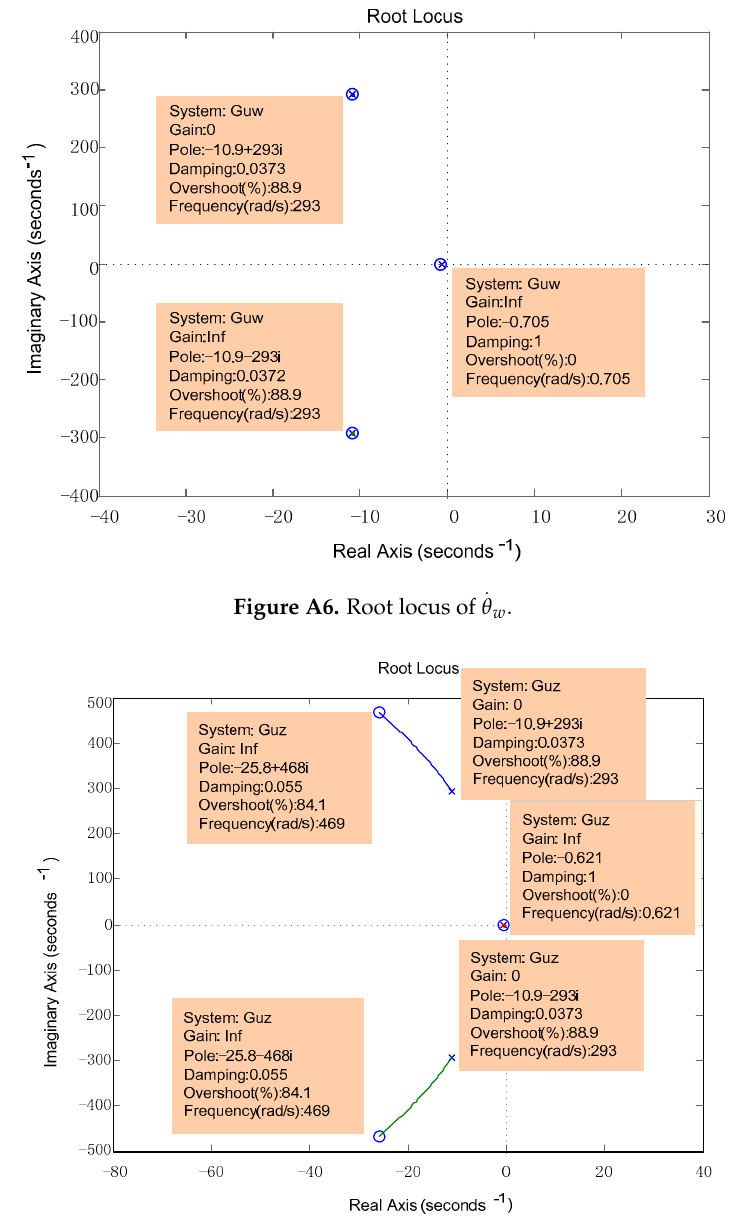
Figure A7. Root locus of transmission torque τ .